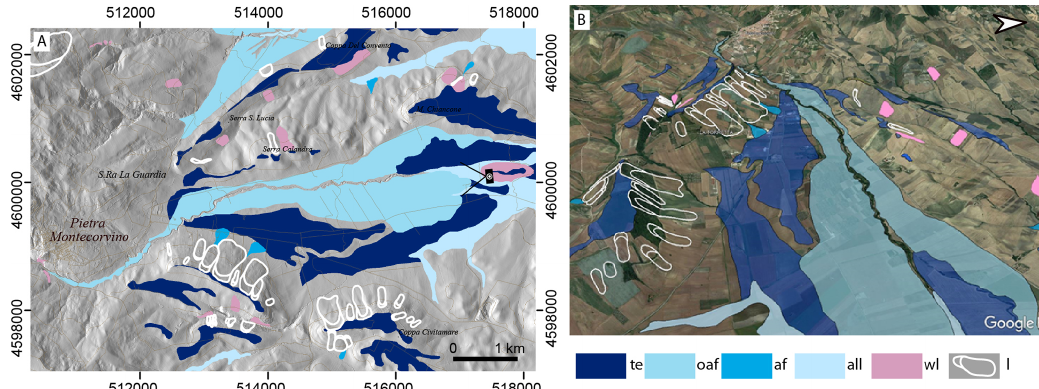
Figure 8. (a) Excerpt of the landslide inventory map. Landslides were coloured in white to enhance the geomorphological elements. (b) Birds-eye view of the same area as (a) prepared using © GoogleEarth™. In the legend: te, fluvial terrace; oaf, old alluvial fan; af, alluvial fan; all, alluvial deposits; wl, widespread landslide; l,